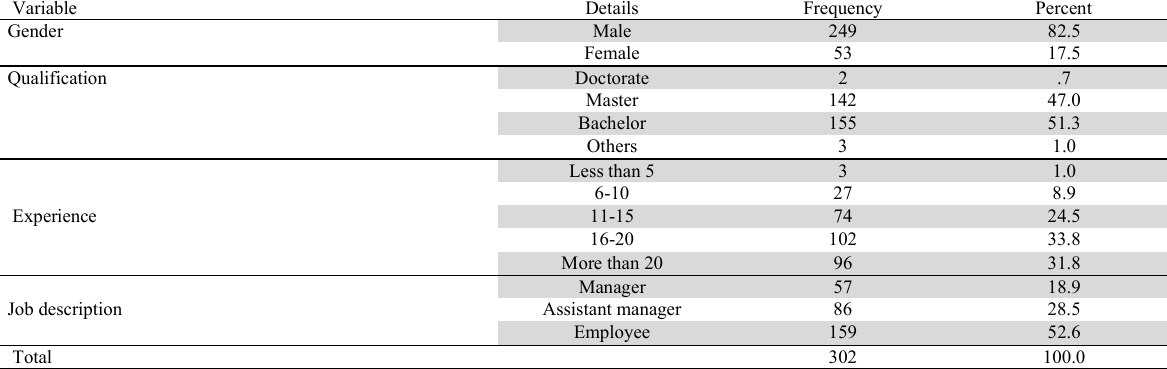
The demographic characteristics of the sample Variable